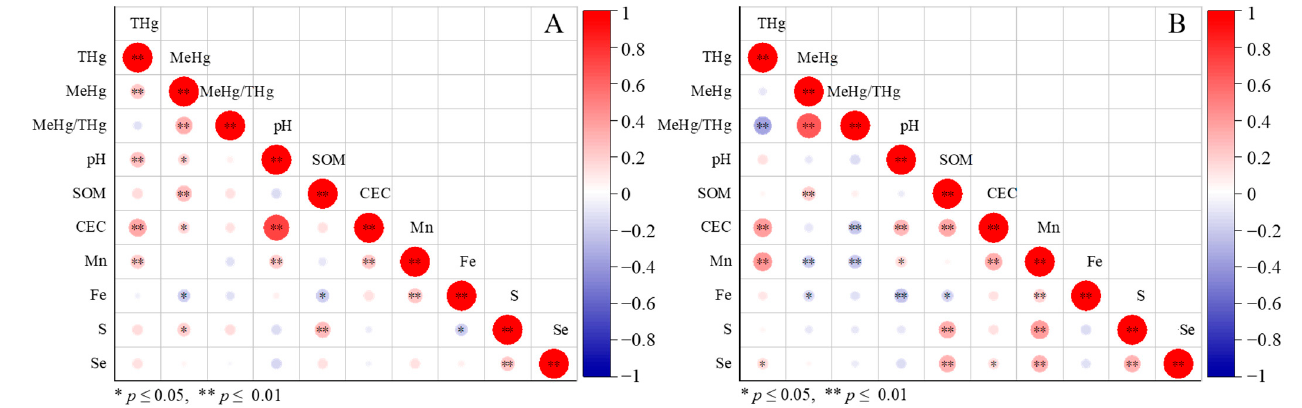
Figure 6. Correlation between Hg and soil physical and chemical properties in mining ( A ) and smelting areas ( B ).